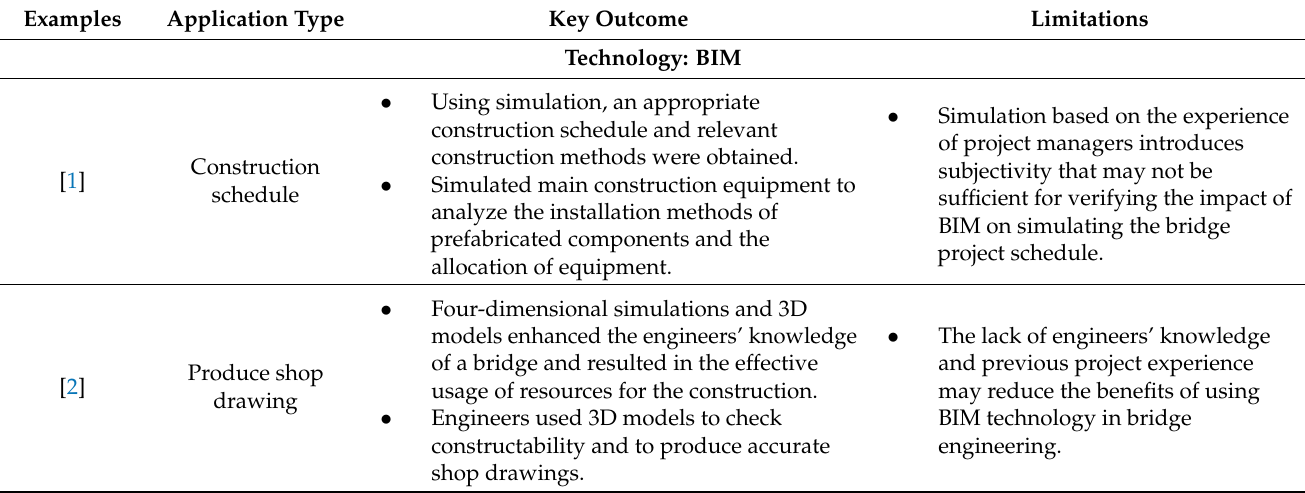
Table 4. BIM/GIS uses in